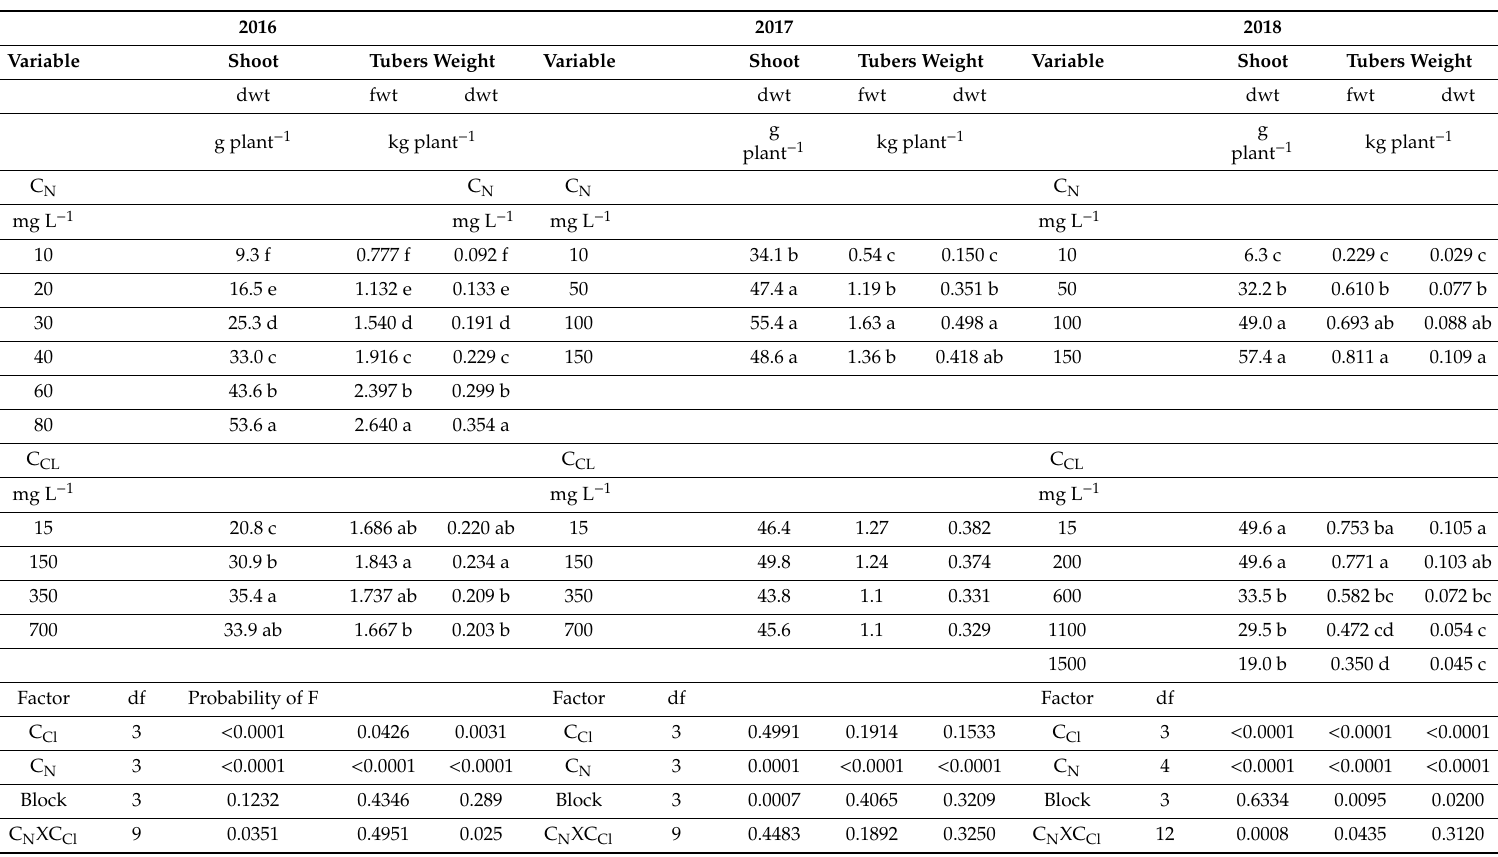
Table 4. The e ff ect of C N and C CL on potato shoot dry weight and tubers fresh and dry weight and N, Cl, and nitrate-N concentrations in leaf tissue. Probability of F values for C N , C Cl , Block factors, and the interaction of C N and C Cl were determined using the two-way ANOVA procedure of JMP 14. Di ff erent letters on the right side of values indicate significant di ff erence between treatments (HSD) at p < 0.05 by the Tukey–Kramer honestly test. No letters are presented when no significant di ff erence was